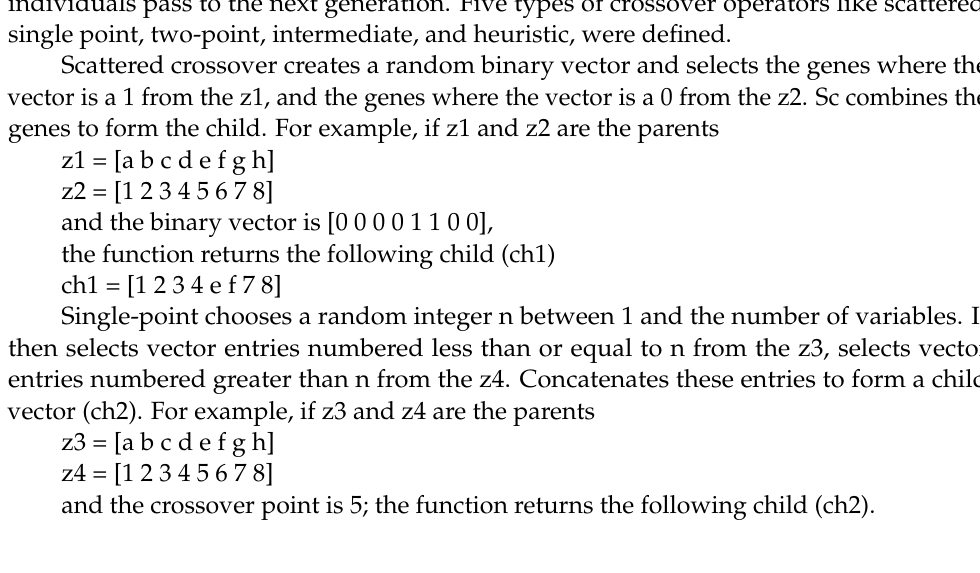
tournament, were included in this